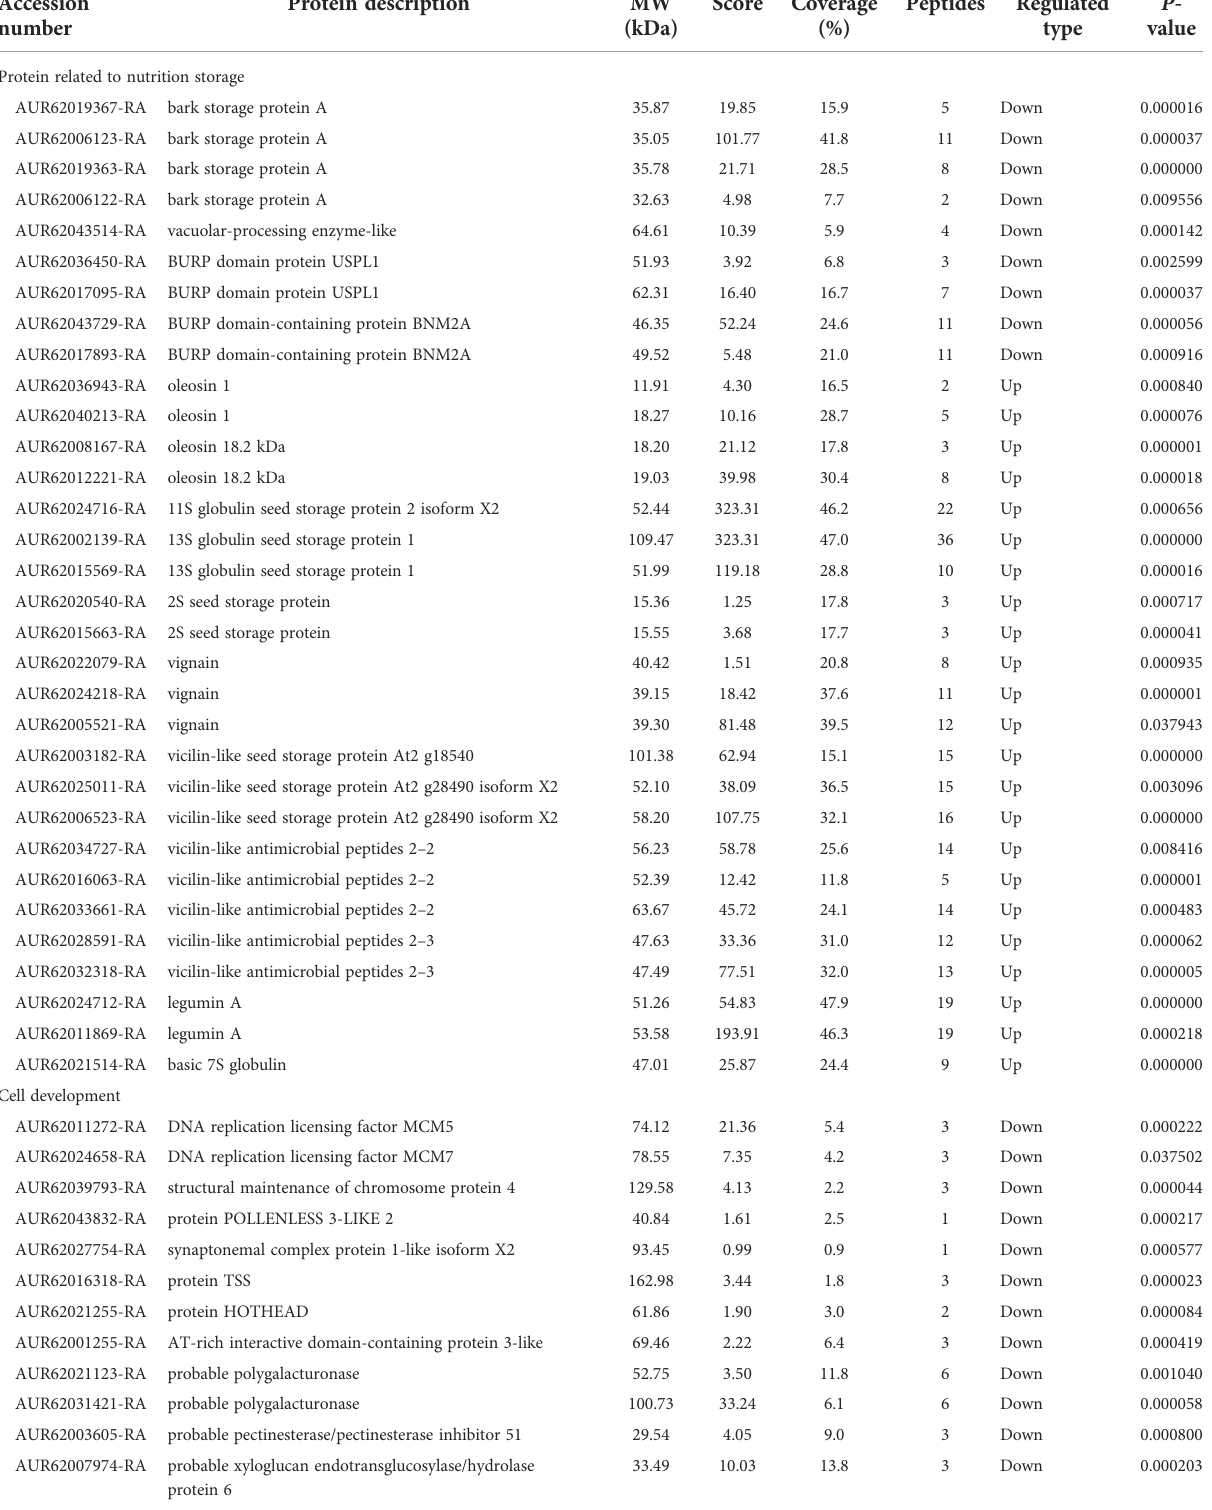
TABLE 2 Differentially accumulated proteins (DAPs) participating in cell development and protein related to nutrition storage in Chenopodium quinoa Willd.